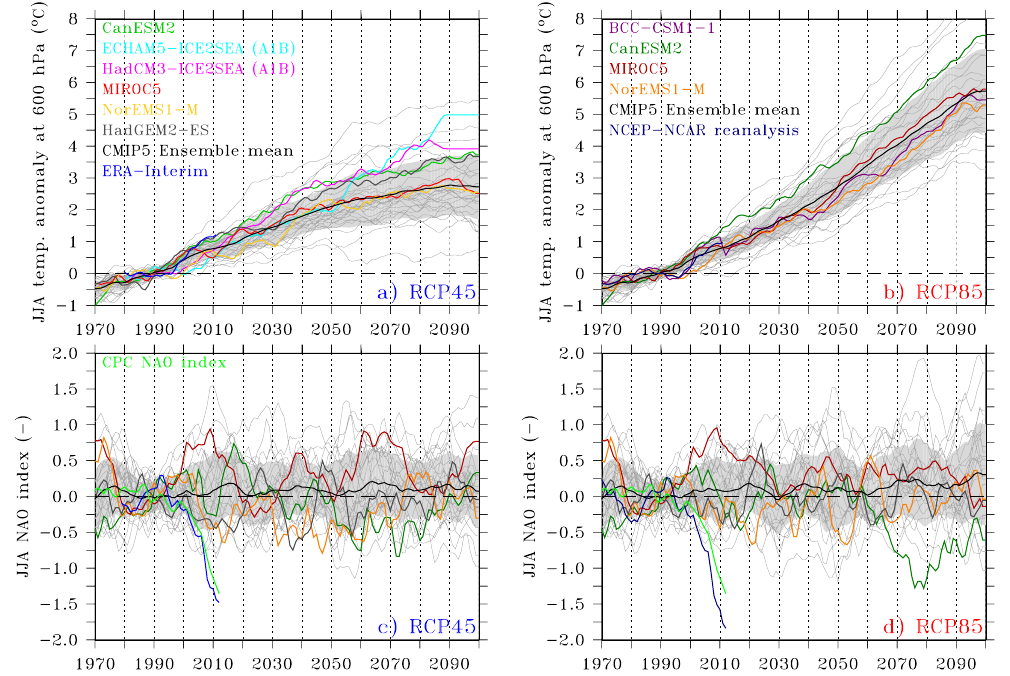
Fig. 3. (a) Anomaly of JJA temperature at 600hPa (T600) simulated by the reanalyses and the CMIP5 GCMs with respect to 1980–1999 over Greenland for the RCP 4.5 scenario. The anomaly of T600 is taken over an area covering Greenland (20–70 ◦ W, 60–85 ◦ N). The ensemble mean as well as the standard deviation of the 30 CMIP5 GCMs are plotted in dark black and in light grey, respectively. Finally, the projections from GCMs used in this study are drawn in colour and a 10-yr running mean is applied for smoothing the curves. (b) Same as (a) but for RCP 8.5. (c) Same as (a) but for a proxy of the JJA NAO index. The NAO index is here estimated as the standardized (over 1980–1999) difference of the JJA air pressure at sea level (PSL) between the Azores (27 ◦ W, 39 ◦ N) and Iceland (22 ◦ W, 64 ◦ N). The “real” JJA NAO index from the Climate Prediction Center (CPC) (http://www.cpc.ncep.noaa.gov/) is plotted in light green as a comparison. It is also normalised over 1980–1999. (d) Same as (c) but for